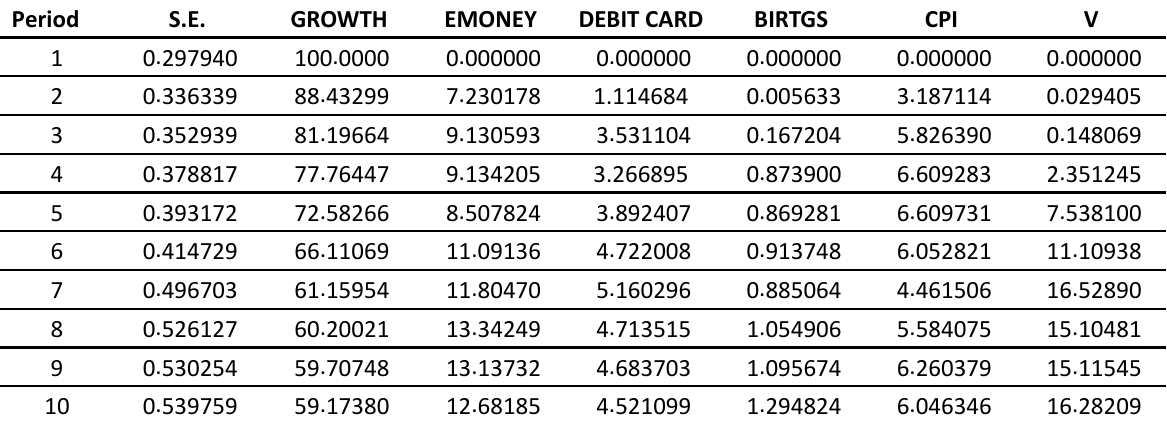
Table 7: Results of Forecast Error Variance Decomposition (FEVD) from the Economic